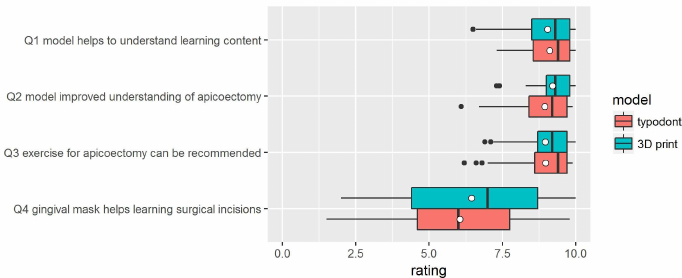
Figure 11. Results of questionnaire. The white dots denote the mean values.